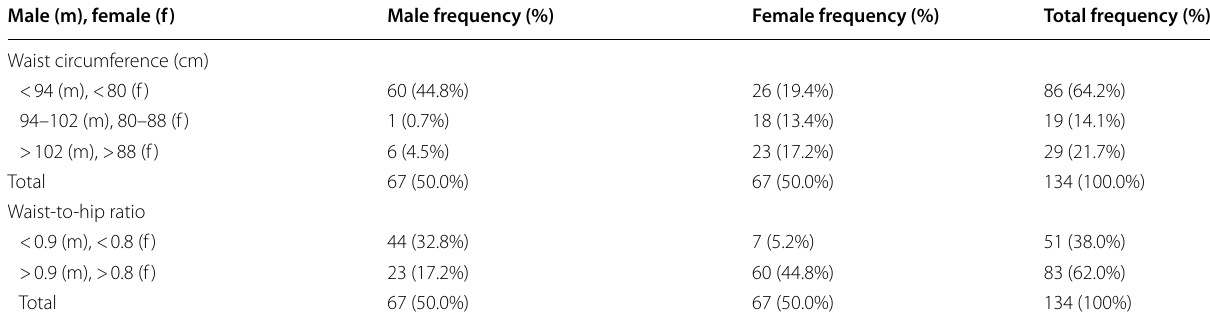
Table 2 Distribution of waist circumference and waist-to-hip ratio Male (m), female (f) Male frequency (%)